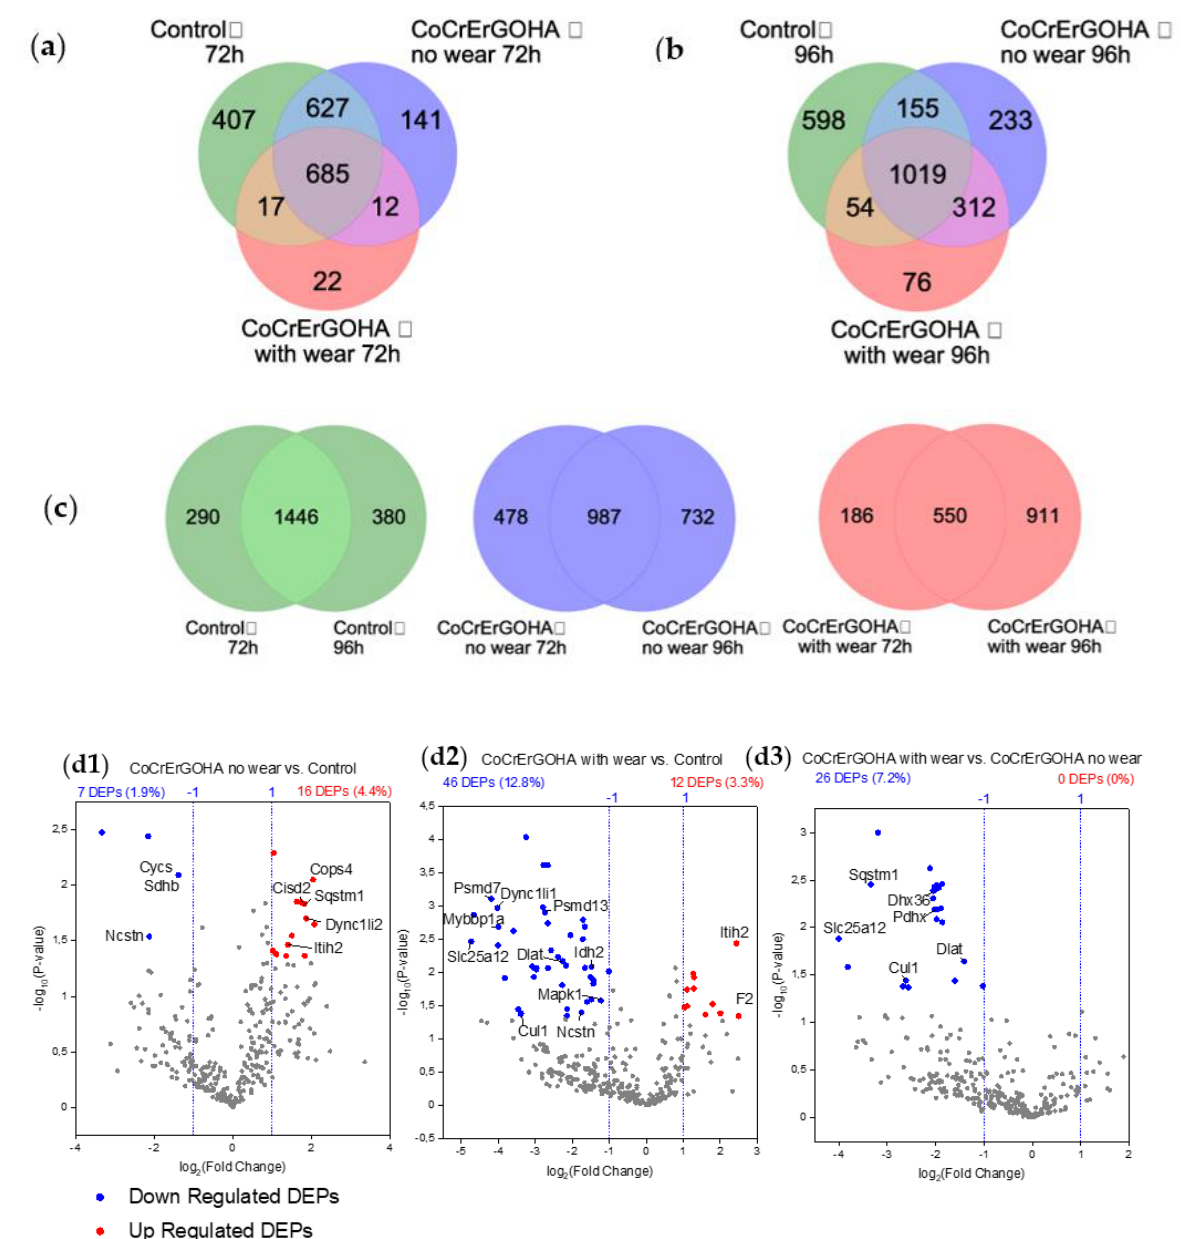
Figure 4. Proteomic profiling of J744A.1 macrophages in response to CoCrErGOHA surfaces: ( a , b ) Inter-group Venn diagrams showing the total number of proteins identified in macrophage proteome exclusively expressed in a group or shared between groups, after 72 h and 96 h of biomaterial interaction; ( c ) Intra-group Venn diagrams showing the total number of proteins identified in macrophage proteome in each group, exclusively expressed after 72 h or 96 h or shared expression at both times of exposure; ( d ) Pairwise volcano plots ( d1 – d3 ) showing differentially expressed proteins (DEPs) between pairwise group comparisons: CoCrErGOHA no wear vs. control ( d1 ) CoCrErGOHA with wear vs. control ( d2 ), CoCrErGOHA with wear vs. CoCrErGOHA no wear ( d3 ); Statistically significant DEPs were computed by Student’s t-test pairwise comparisons with a p -value < 0.05.